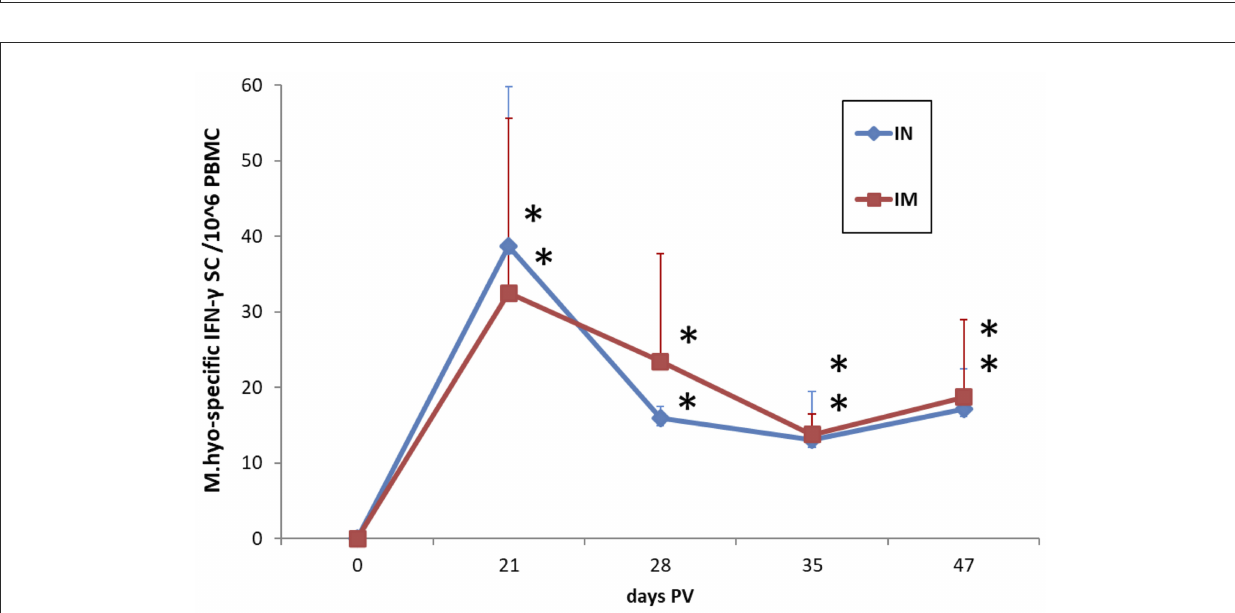
FIGURE8 Frequencies of M. hyopneumoniae -specific IFN- γ secreting cells in PBMC of IN-vaccinated (nano-adjuvanted dry powder vaccine) and IM-vaccinated piglets. PBMC were recalled ex vivo with inactivated M. hyopneumoniae at a ratio of 100 bacterins/cell ( ∼ 50 µ g/ml) for 20h. The levels are reported after subtraction of the values in the corresponding unstimulated cell samples and normalized to 10 6 PBMC. Asterisks (*) indicate a statistically significant difference between the corresponding treatment group and the control group ( p < 0.05). The mean value of the mock-vaccinated control group at 0 days PV (value = 0) was used as reference value for group comparisons throughout the study period. IN, intranasally; IM, intramuscularly; M.hyo, M. hyopneumoniae ; SC, secreting cells; PV,